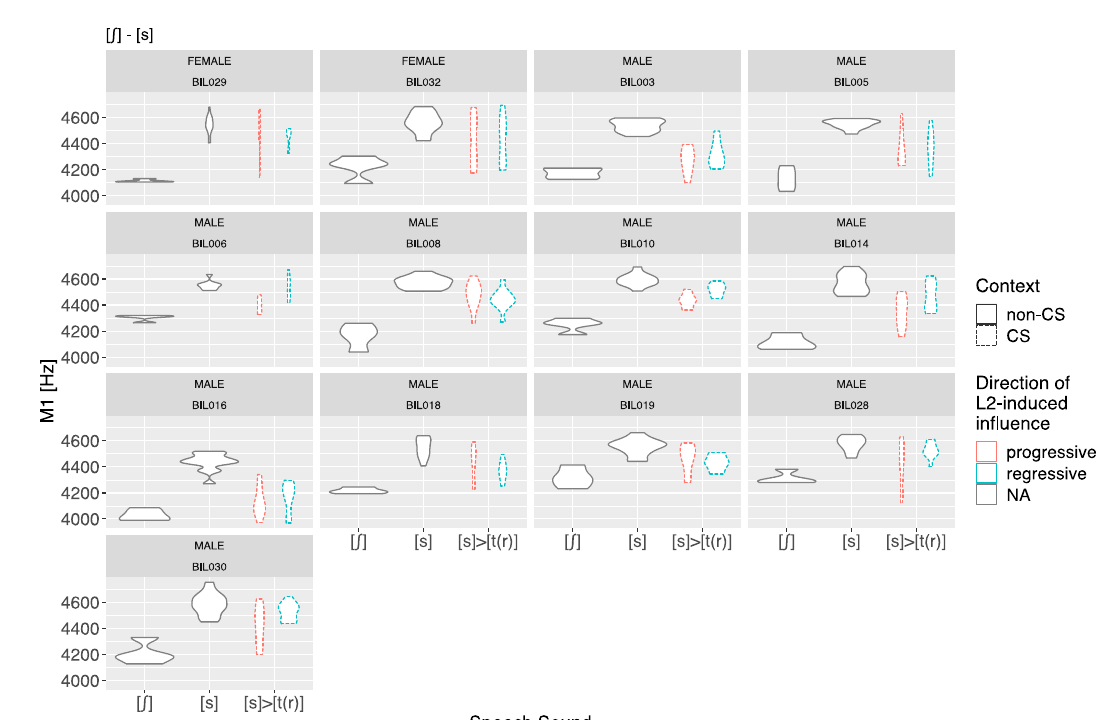
Figure 8. The first spectral moment of intended [ ʃ ] and [s] sounds in English words, spoken by 13 (2 female, 11 male) of the 25 BIL speakers, in non-CS (black), and of [s] in CS (colored) environments, with the latter being divided into contexts with possible progressive (red) and regressive (green) L2-induced influences.